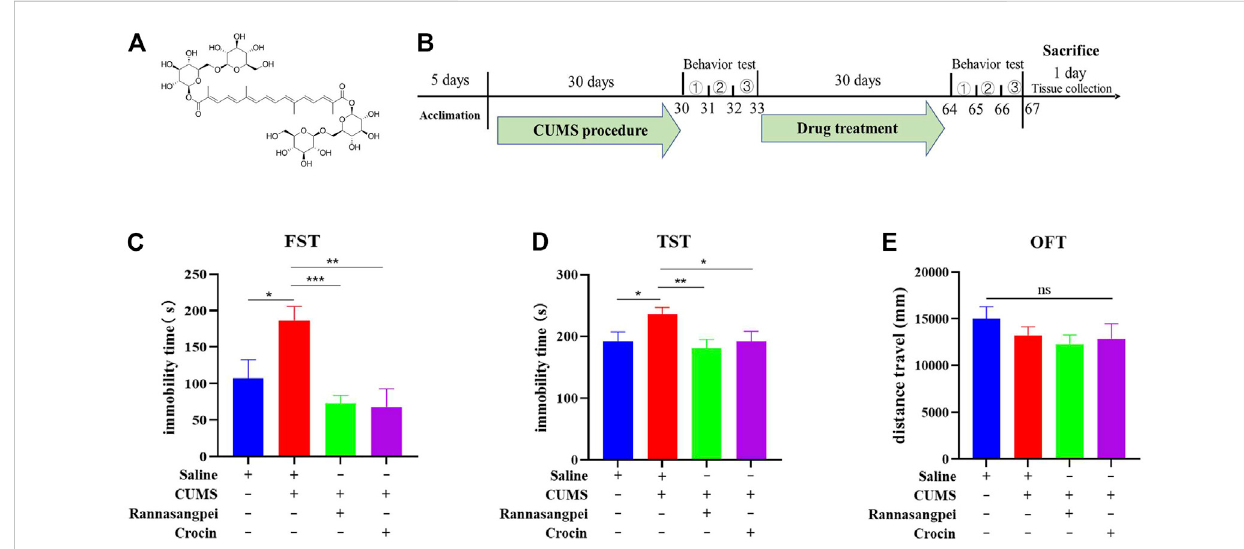
FIGURE 1 RSNPandcrocin-1rescuedstress-induceddepressive – likebehaviorsinmice. (A) Themolecularstructureofcrocin-1. (B) Schematicrepresentation of the experimental design. RSNP or crocin-1 reduced immobility time in CUMS-treated mice as measured by the FST (C) and TST (D) . (E) The OFT suggested that locomotor activity in mice was not altered by RSNP or crocin-1 treatment (the y -axis represents the total distance traveled during the entire testing period). FST, forced swimming test; OFT, open- fi eld test; TST, tail suspension test; RSNP, rannasangpei; CUMS, chronic unpredictable mildstress.,representOFT,TSTandFST,respectively.N=10.ForANOVAstatistics: (C) ,F (3,40) =7.472, p < 0.001; (D) ,F (3,40) =3.905, p =0.025; (E) ,F (3,40)